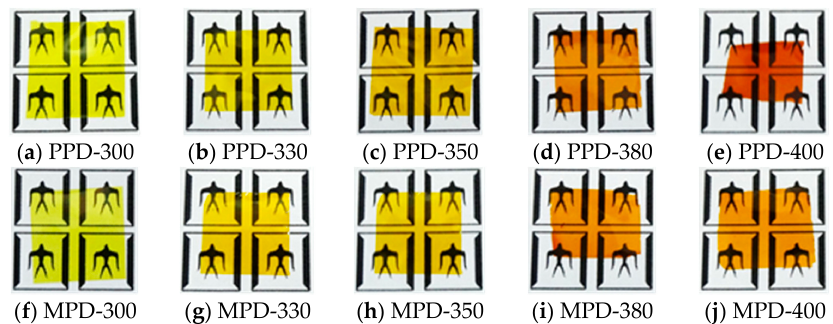
Figure 2. Photo images of the PI films cured at different temperatures: ( a – e ) PI films derived from PPD (PPD-PIs), and ( f – j ) PI films derived from MPD (MPD-PIs). Fang et al. [16] reported that the degree of reaction at the phenylethynyl group can be detected